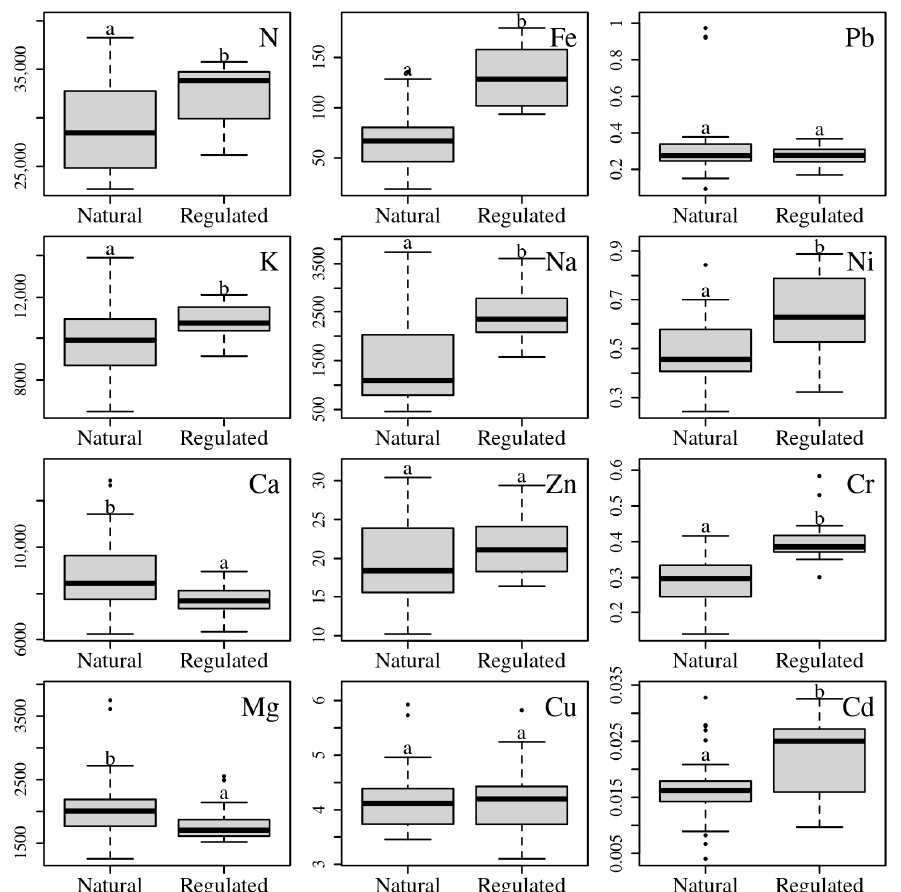
Figure 5. Median values (box–whisker plots) of leaf element concentrations (µg/g d. m. in y axes) of L. salicaria populations growing near natural and regulated riverbeds. The central line of each box indicates the median value; the boxes, the lower (25%) and upper (75%) quartiles; the whiskers are from the 10th to 90th percentiles (typical range); the points are outliers. Population groups marked with distinct letters differ significantly ( p < 0.05).